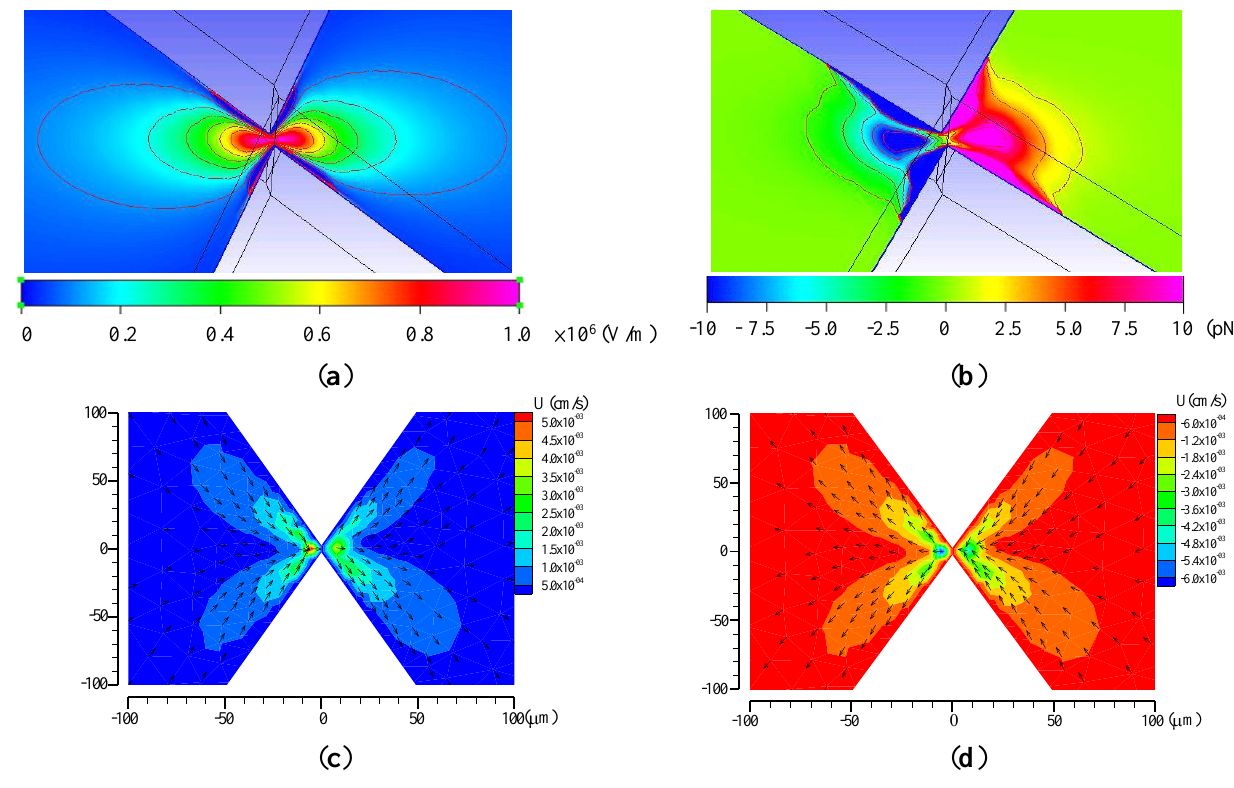
Figure 3. Numerical contours of the ( a ) E 90 V ·cm −1 with a driving frequency of 1 kHz. Numerical results of ( c ) forward EOF at a pp driving frequency of 1 kHz and ( d ) backward EOF at a driving frequency of 5